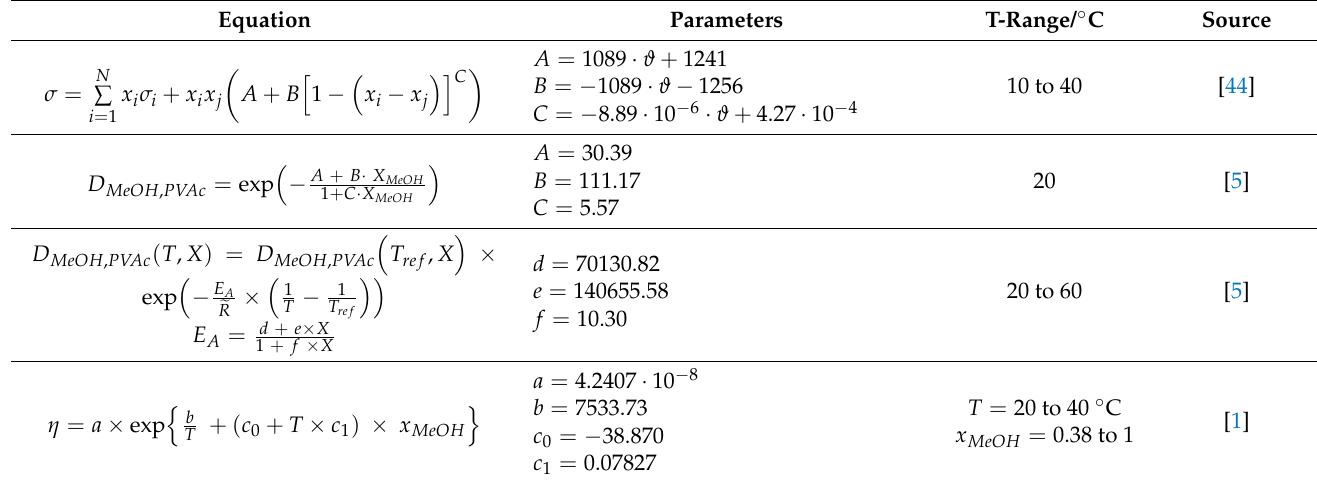
Table A5. Concentration-dependent properties from poly (vinyl acetate)-methanol solutions with strong concentration dependency and with ϑ being the temperature in ◦ C, as well as x MeOH and X MeOH being the methanol mass fraction and methanol solvent load,